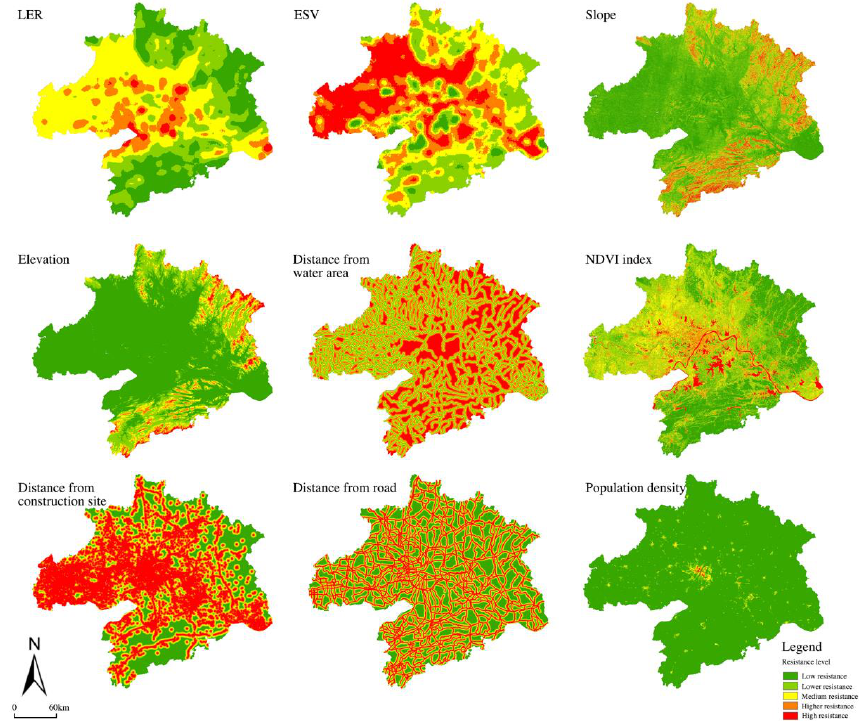
Figure 8. Spatial distribution of ecological resistance factors.